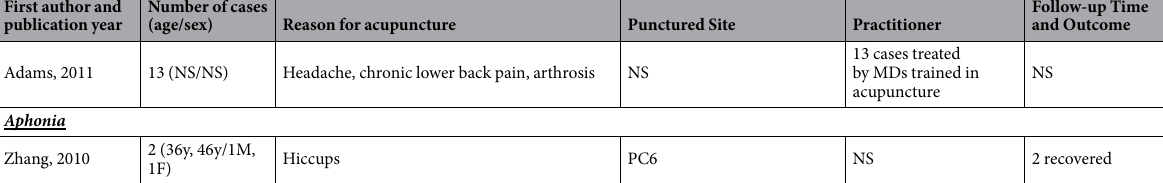
Table 3. Most common adverse events and complications associated with acupuncture. Keys: NS, not stated; y, year; F, female; M, male; TCM, traditional Chinese medicine; MD, doctor of medicine; ~,